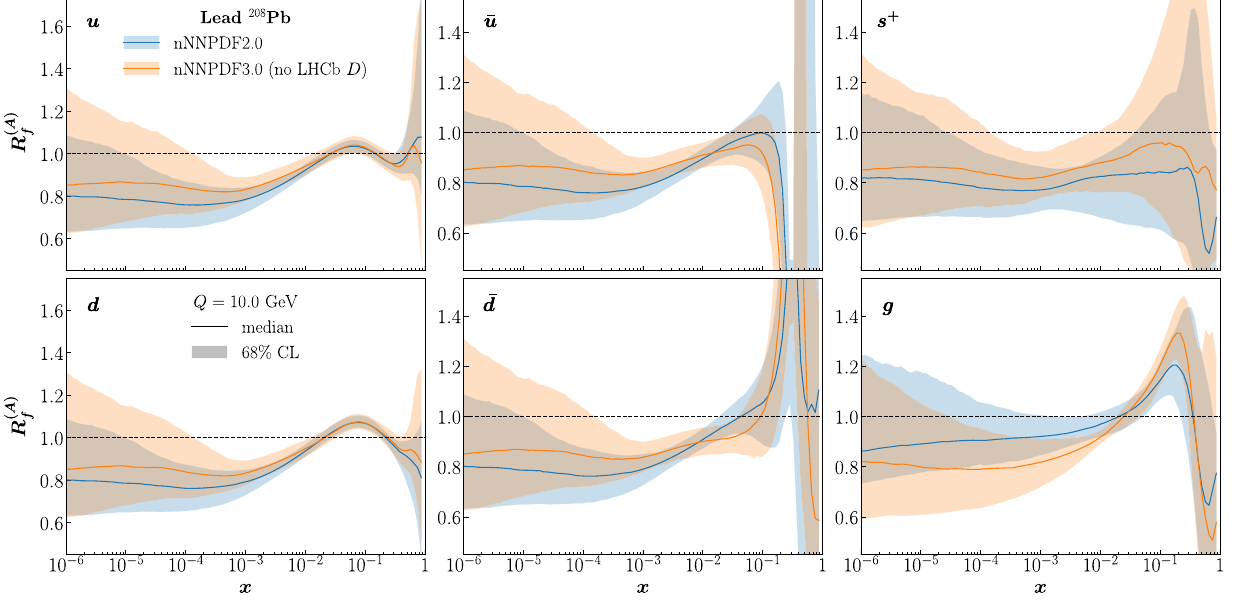
Fig. 6 Same as Fig. 5 now in terms of the nuclear modification ratios R ( A )